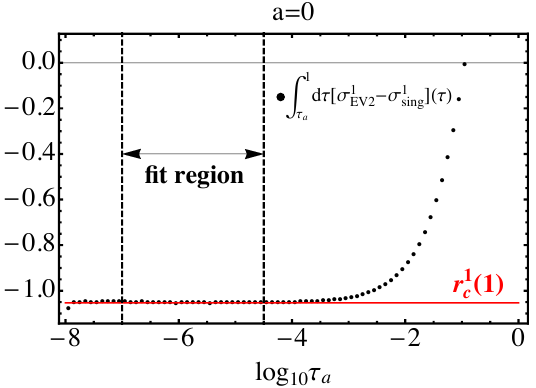
( (cid:11) s ) remainder function from EVENT2 as a function of the O 0, a suitable (cid:12)tting region is indicated that gives the constant !